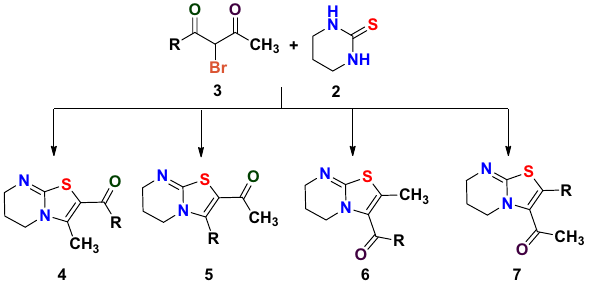
Figure 1. Showing four possible products on the reaction of α-bromo-1,3-diketone with terahydropyrimidine- 2( H